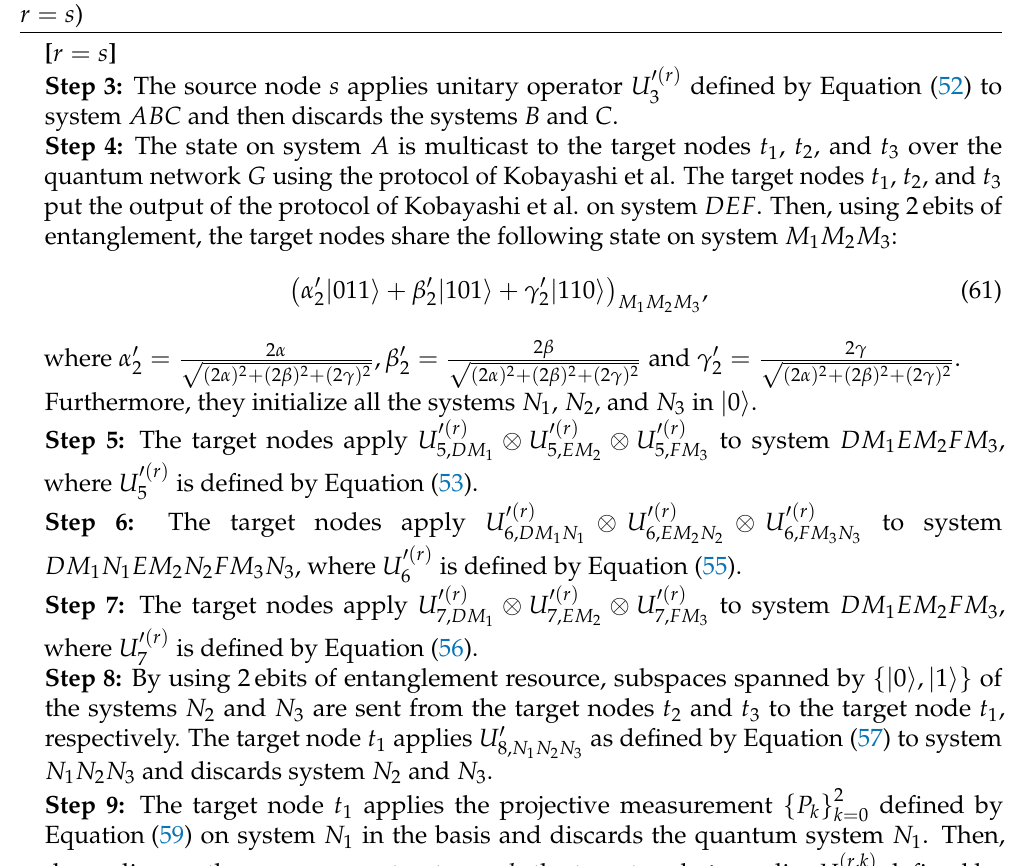
Protocol 5 Continuation of Protocol 3 for 1 → 3 quantum multicast network coding